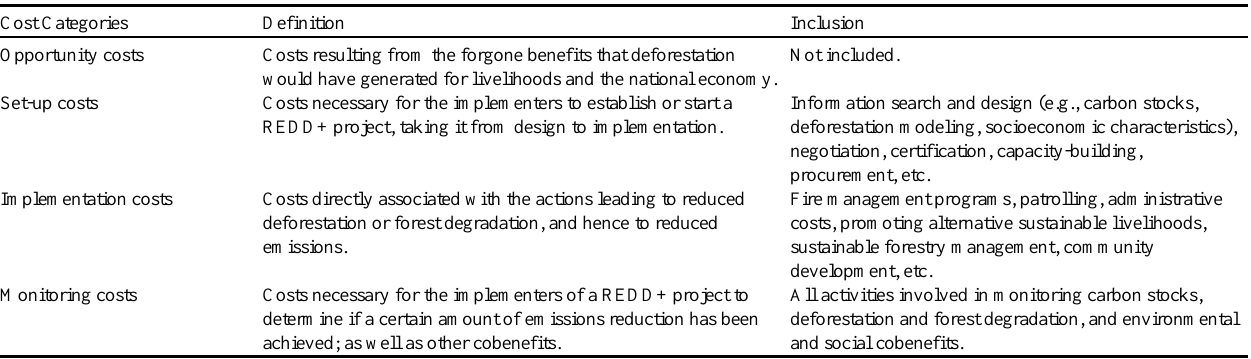
Table 1 . Definition of cost categories of REDD+ projects in this